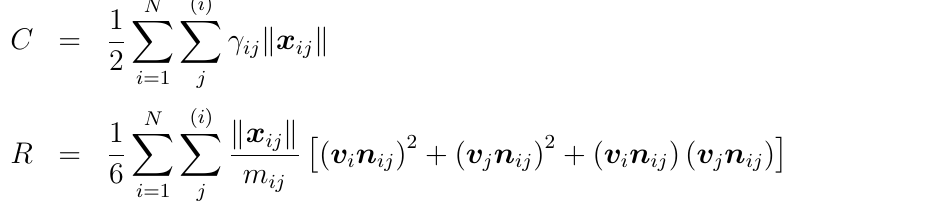
Figure 7. Using straight grain boundaries will also alter the boundary migration rates. This is considered to be the main cause of mismatch in comparing recrystallization kinetics obtained from a vertex model to that of a Monte Carlo Potts model in [123]. Better agreement with Monte Carlo Potts kinetics is found in [125] where also intermediate vertices are